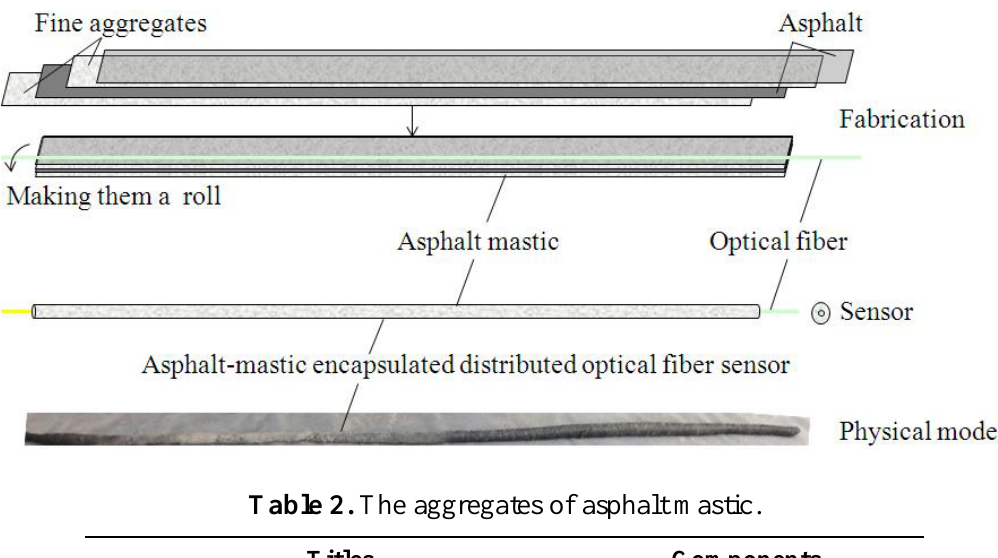
Figure 8. Manufacturing process of an asphalt-mastic encapsulated distributed OF sensor.